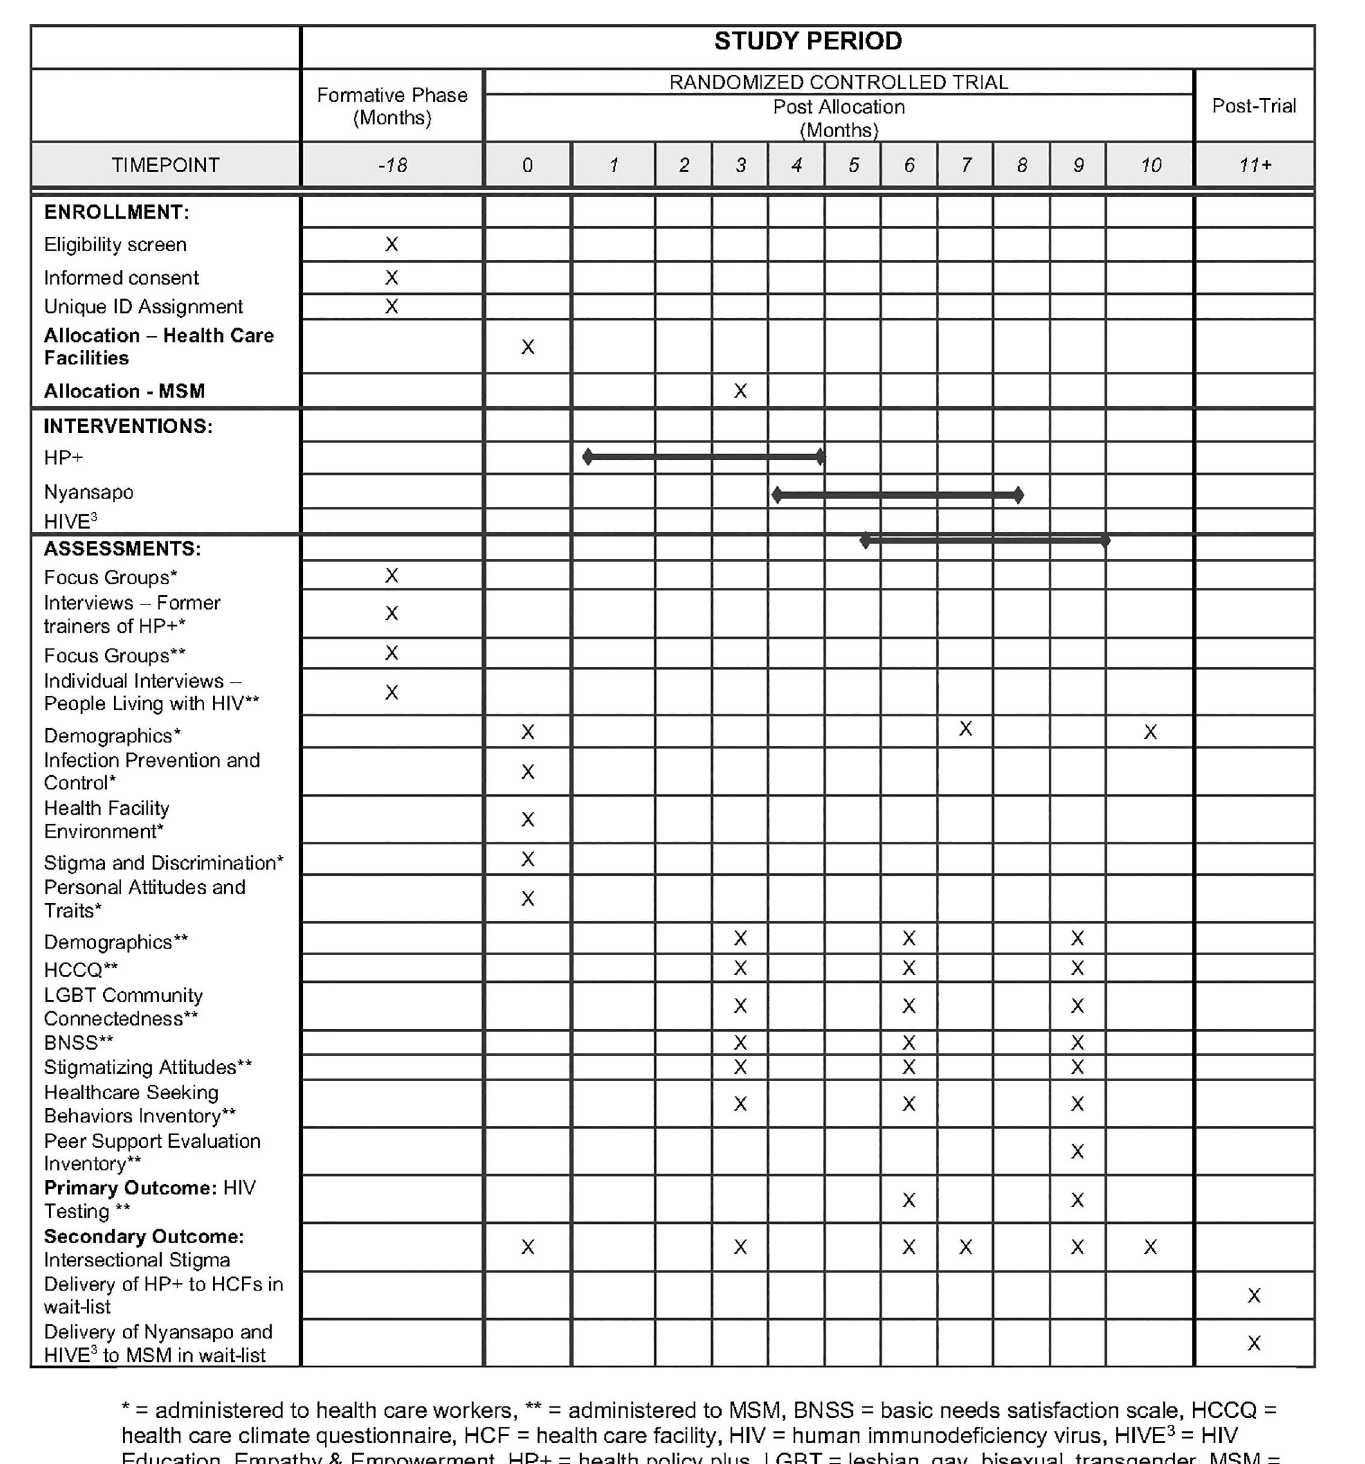
Fig 1. Schedule of enrollment, interventions, and assessments. � = administered to health care workers, �� = administered to MSM, BNSS = basic needs satisfaction scale, HCCQ = health care climate questionnaire, HCF = health care facility, HIV = human immunodeficiency virus, HIVE 3 = HIV Education, Empathy & Empowerment, HP+ = health policy plus, LGBT = lesbian, gay, bisexual, transgender, MSM = men who have sex with men.